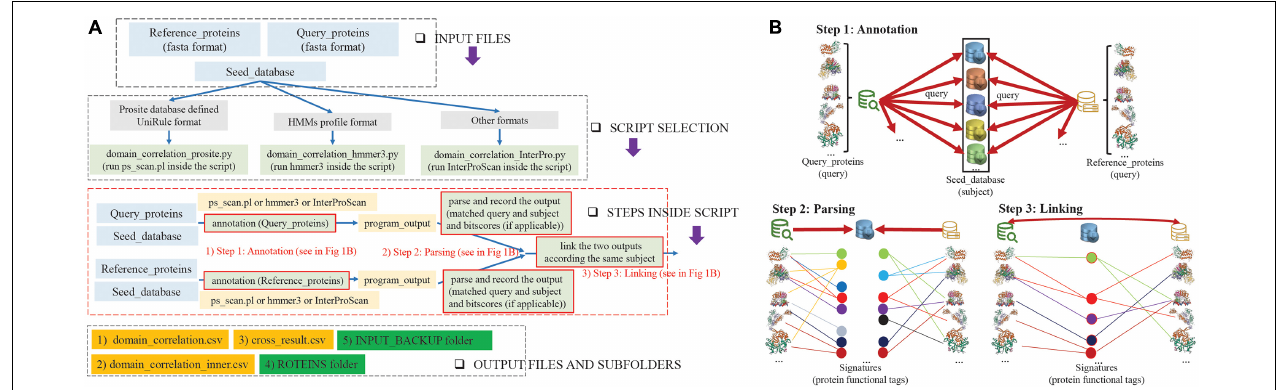
FIGURE 1 | Overview of Duo workflow. (A) Flowcharts of the steps in the application of Duo. INPUT FILES: Before the analysis, user needs to prepare three files containing the protein coding sequences that needs to be analyzed (Query_proteins), a set of sequences that are known to encode proteins of the wanted quality (Reference_proteins), and a database to search in (Seed_database). SCRIPT SELECTION: Seed_databases are in different formats, and to make it possible to use Duo broadly, it contains different python scripts to be selected depending on the format of Seed_database. STEPS INSIDE SCRIPT: The data processing steps of Duo (further descripted in Figure) consists of three general steps. (1) ANNOTATION: the Query_proteins and Reference_proteins are annotated separately according to the Seed_database. (2) PARSING: The annotation results are parsed and recorded. (3) LINKING: The parsed annotation results from Query_proteins and Reference_proteins are linked. OUTPUT FILES AND SUBFOLDERS: Based on the analysis, Duo constructs three output files. (1) Domain_correlation.csv gives details of all the correlation records (parsed annotation results from Query_proteins and Reference_proteins). (2) Domain_correlation_inner.csv gives details of the correlation records shared between the linked Query_proteins and Reference_proteins. (3) Cross_result.csv records the delta-bitscores between the linked Query_proteins and Reference_proteins. The output further contains two sub-folders (4) PROTEINS, which gives records of the functional similar proteins among Query_proteins and Reference_proteins and (5) INPUT_BACKUP, which backs up the original files of Query_proteins and Reference_proteins. (B) A schematic illustration of the three steps in Duo analysis. Step 1: Separately, Query_protein and Reference_proteins are used as query inputs to query the